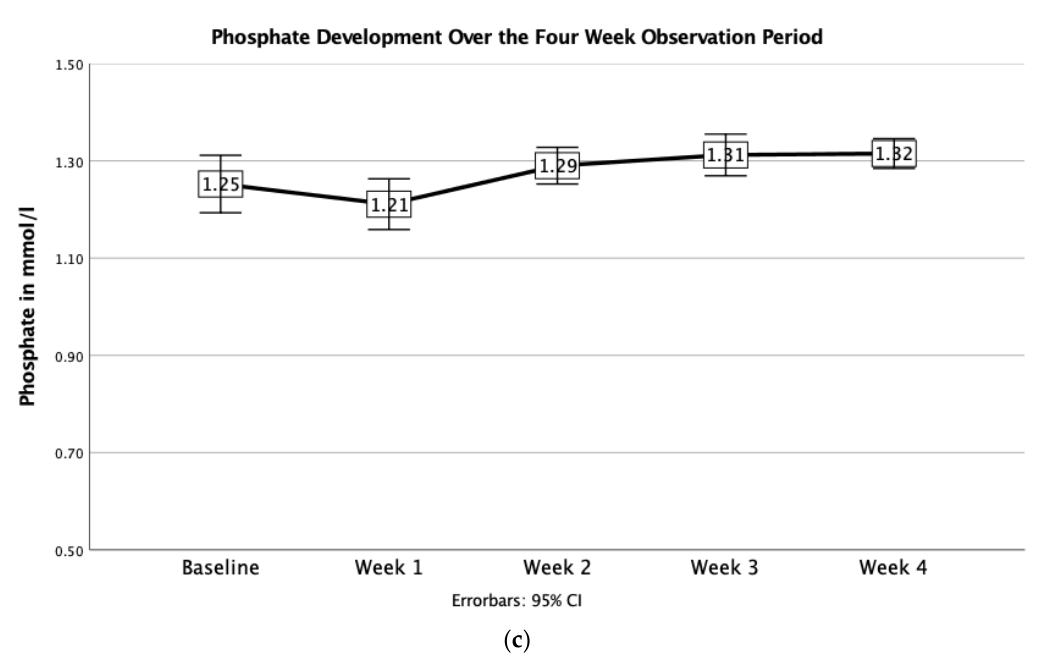
Figure 1. ( a ) Development of body weight over 28 days. ( b ) Development of BMI over 28 days. ( c ) Development of serum phosphate over 28 days.